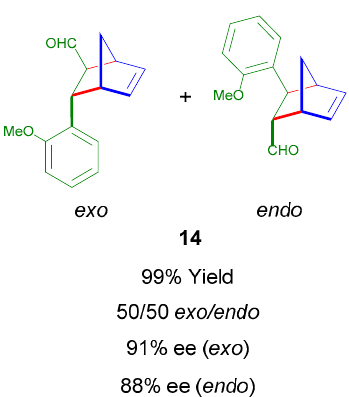
Figure 4. DA adducts 14 from ( E )-2-methoxycinnamaldehyde and 8 catalyzed by ICCC 6 .